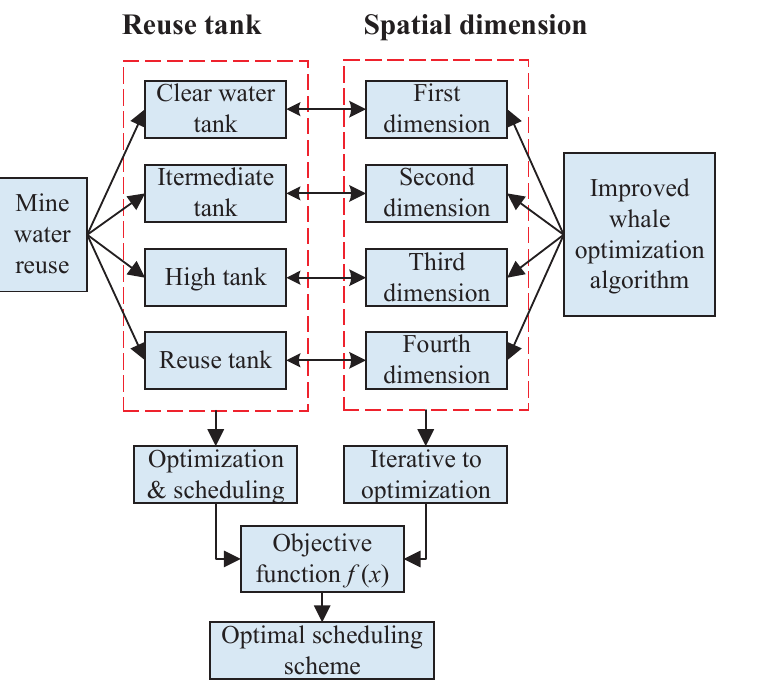
Figure 12. Schematicdiagramofminewaterschedulingbasedonimprovedwhaleoptimizationalgorithm.